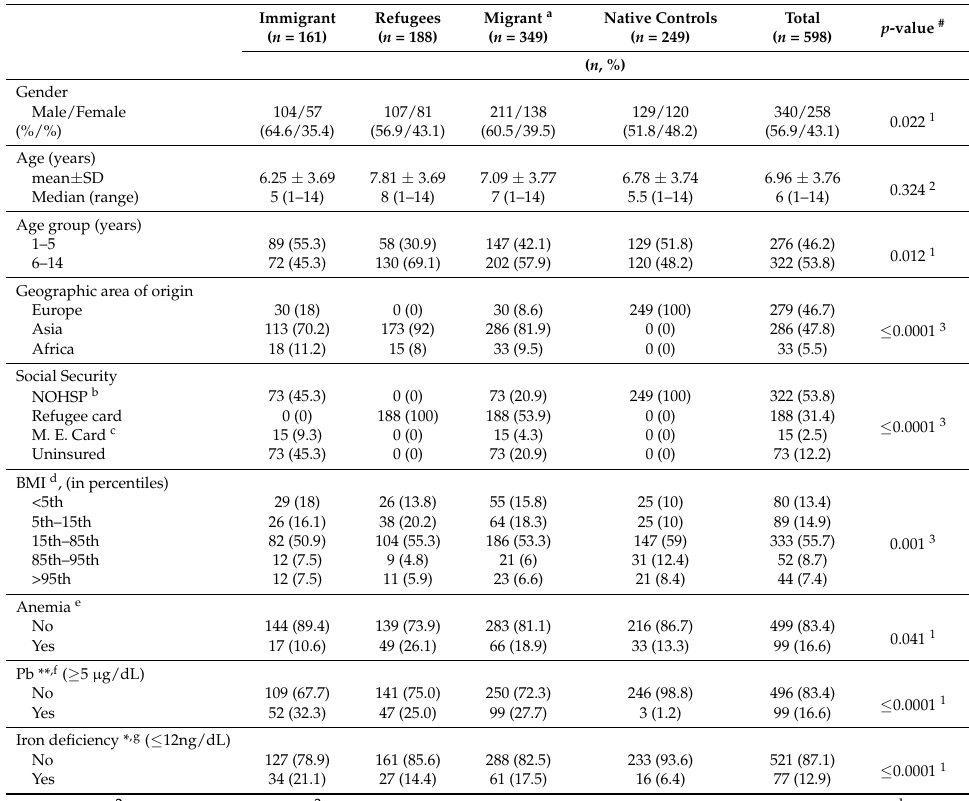
Table 1. Characteristics and laboratory evaluation of new migrant ( n = 349) and native ( n = 249) children.